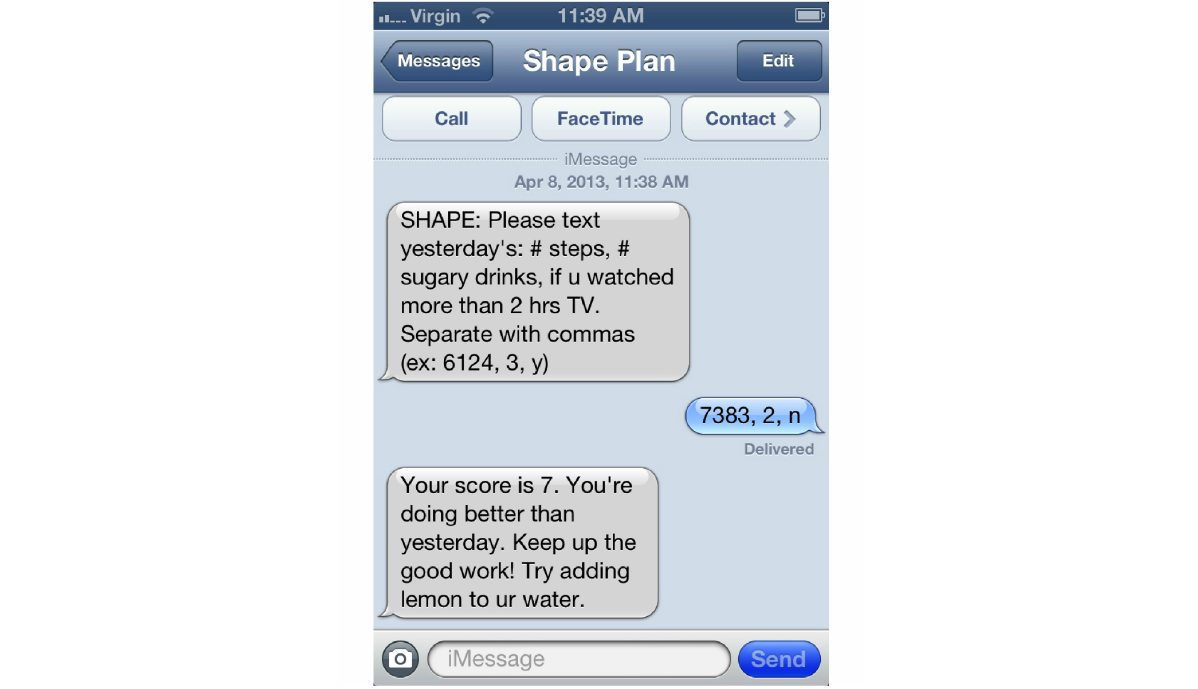
Figure 1. Screenshot of self-monitoring via text message with